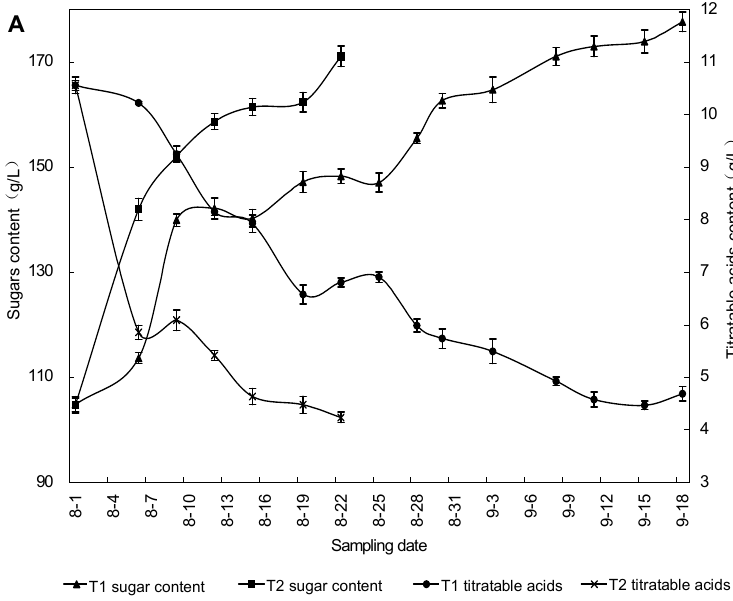
Figure 1. Changes of sugar and titratable acids in grape berry during ripening period in the 2010 ( A ) and 2011 ( B )